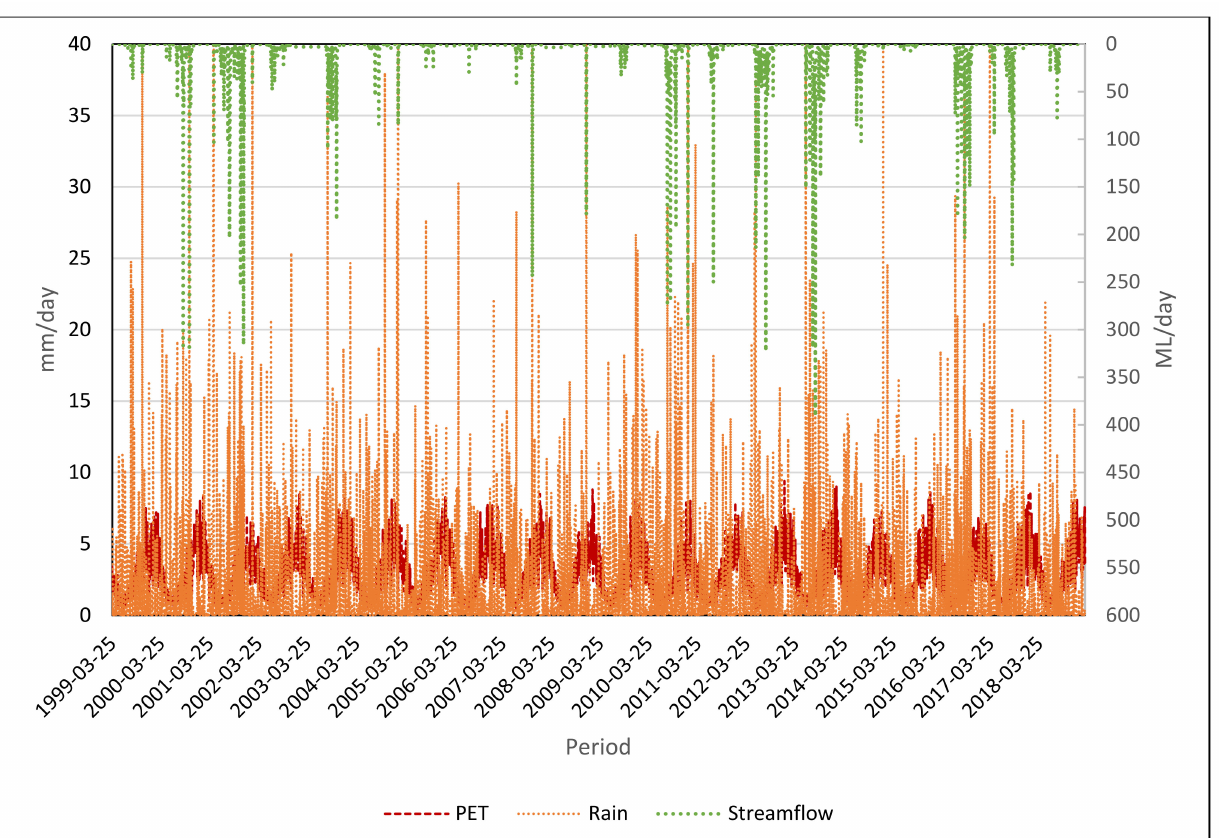
Figure 3. PET, rainfall and observed streamflow time series